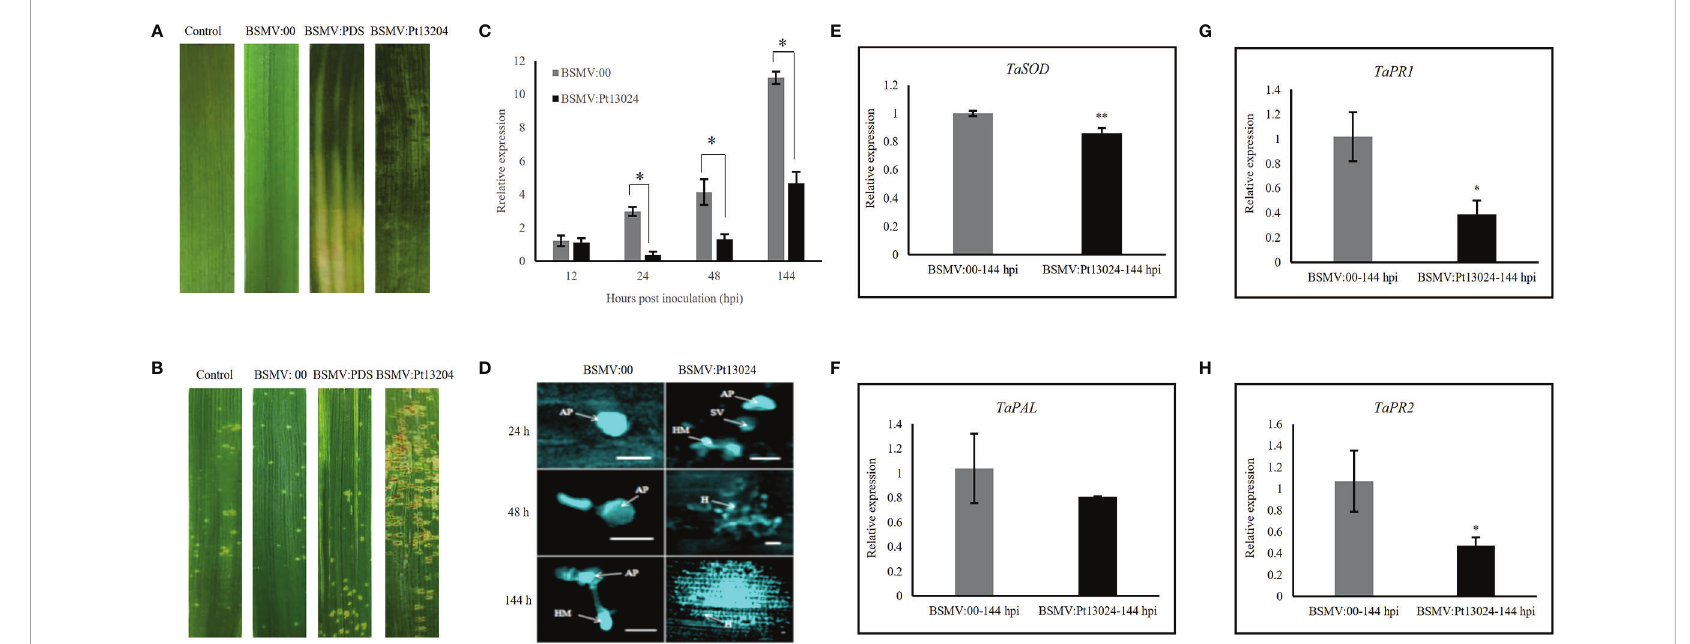
FIGURE 7 Silencing Pt13024 increased the virulence of Pt 13-5-72 on TcLr30. (A) The second leaf of TcLr30 was inoculated with sodium phosphate buffer, barley stripe mosaic virus BSMV:00, and recombinant virus BSMV : PDS and BSMV : Pt13024, which were ampli fi ed by Agroin fi ltration- mediated in N. benthamiana . The virus phenotypes on TcLr30 were observed and photographed at 10 dpi. (B) TcLr30 seedlings were inoculated with the labeled BSMV constructs on the second leaf for 10 days, and then inoculated with urediospores of Pt 13-5-72 (THSN) on the fourth leaf. Leaves infected with Pt were investigated at 14 dpi. Infection type “ ; ” : No uredospore pile, but necrosis or chlorosis; “ 3 ” : The uredinium is medium with chlorosis around. (C) Relative expression of Pt13024 in TcLr30 after inoculation of THSN at 6 d. The transcript levels of Pt13024 genes in leaves in fi ltrated by virus (BSMV:00) were measured, and inoculated Pt was the control. The expression levels the of Pt13024 gene were measured in the leaves infected by the recombinant virus. (*: p < 0.05; **: p < 0.01) (D) Histological observation of wheat TcLr30 in fi ltrated with BSMV and inoculated Pt 13-5-72 (THSN). Bar = 20 µm. (E – H) Transcription level fold changes of plant defense-related genes SOD , PAL , PR1 and PR2 in leaves of Wheat silenced with Pt13024. The relative gene quanti fi cation was calculated by the comparative Ct method with Pt endogenous gene EF1 as an internal standard. Three technical replicates and biological repetition for each treatment were analyzed. Mean and SE values from three independent replicates are shown. Asterisks indicate signi fi cant differences (** p < 0.01, * p < 0.05). AP, appressorium; BSMV, barley stripe mosaic virus; H, haustorium; HMC, haustorial mother cells; IH, infection hyphae; Pt , Puccinia triticina ; SV, substomatal